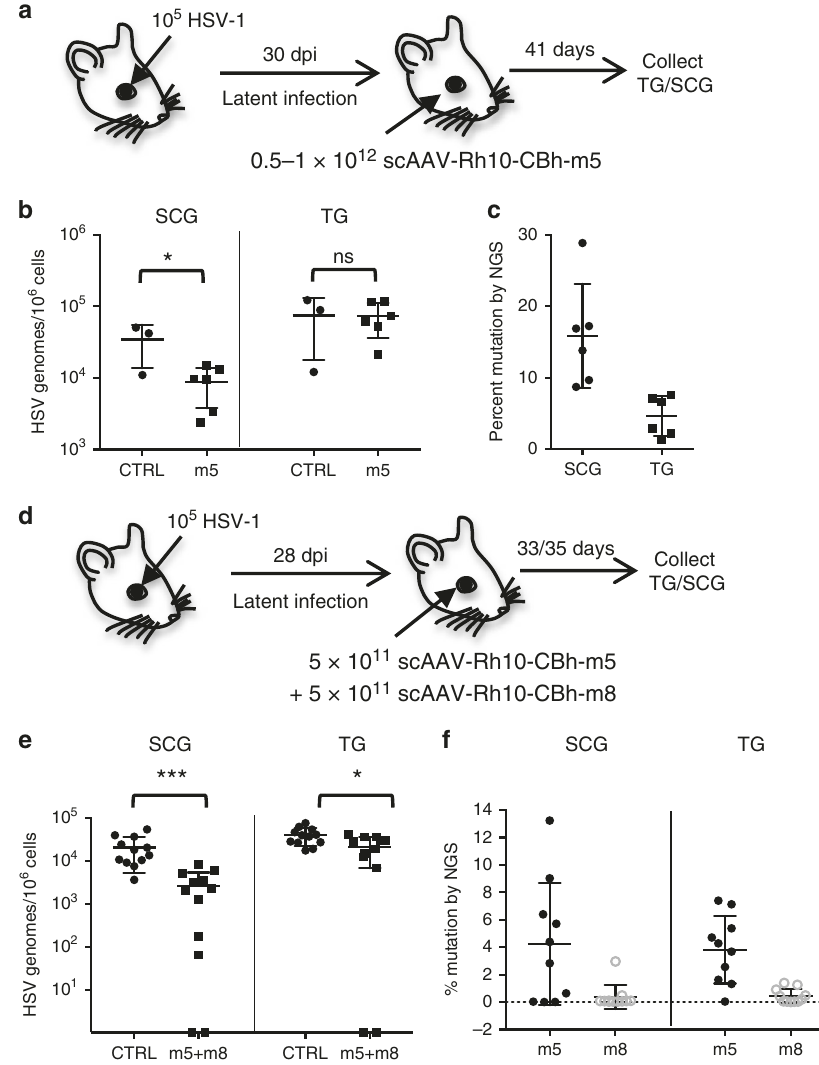
Fig. 2 Ef fi cient gene editing after optimized delivery of dual-meganuclease therapy. a Mice latently infected with 10 5 PFU HSV-1 17 + for 30 days, were administered 0.5 – 1 × 10 12 scAAV-Rh10-CBh-m5 by RO injection. Analysis was performed 41 days later. b ddPCR quanti fi cation of HSV genomes in SCG and right (ipsilateral) TG of control (CTRL, circles n = 3) or m5 (squares n = 6) treated mice. p = 0.017 for SCG. c NGS analysis in SCG and TG from m5- treated mice ( n = 6) to detect HSV gene editing at the m5 target site in SCG (circles) or TG (squares). d Mice latently infected with 10 5 PFU HSV-1 17 + in the right eye for 28 days were administered 5 × 10 11 vgs scAAV-Rh10-CBh-m5 + 5 × 10 11 vgs scAAV-Rh10-CBh-m8 by RO injection. SCGs and ipsilateral TG were collected 33 – 35 days later. e ddPCR quanti fi cation of HSV genomes in TG and SCG from latently infected mice either left untreated (Controls, CTRL circles, n = 12) or administered m5 + m8 (squares, n = 12). p = 0.006 and p = 0.01 for SCG and TG, respectively. f NGS analysis of SCG and TG from treated mice to detect mutations at either the m5 (closed circles) or m8 (open circles) target sites. ns: not signi fi cantly different from controls, * p < 0.05, ** p < 0.01, *** p < 0.001, signi fi cantly different from controls. All data are presented as mean values ± SD. Statistical analysis was conducted using unpaired multiple t -test without correction for multiple comparison. Source data are provided as a Source data fi